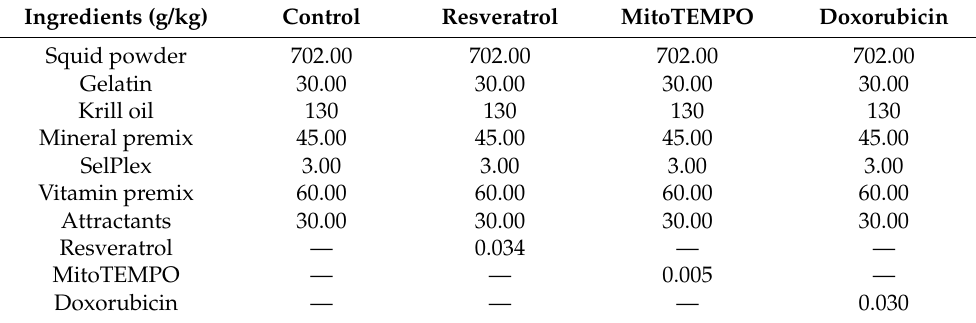
Table 1. Ingredient’s formulation in the experimental microdiets.